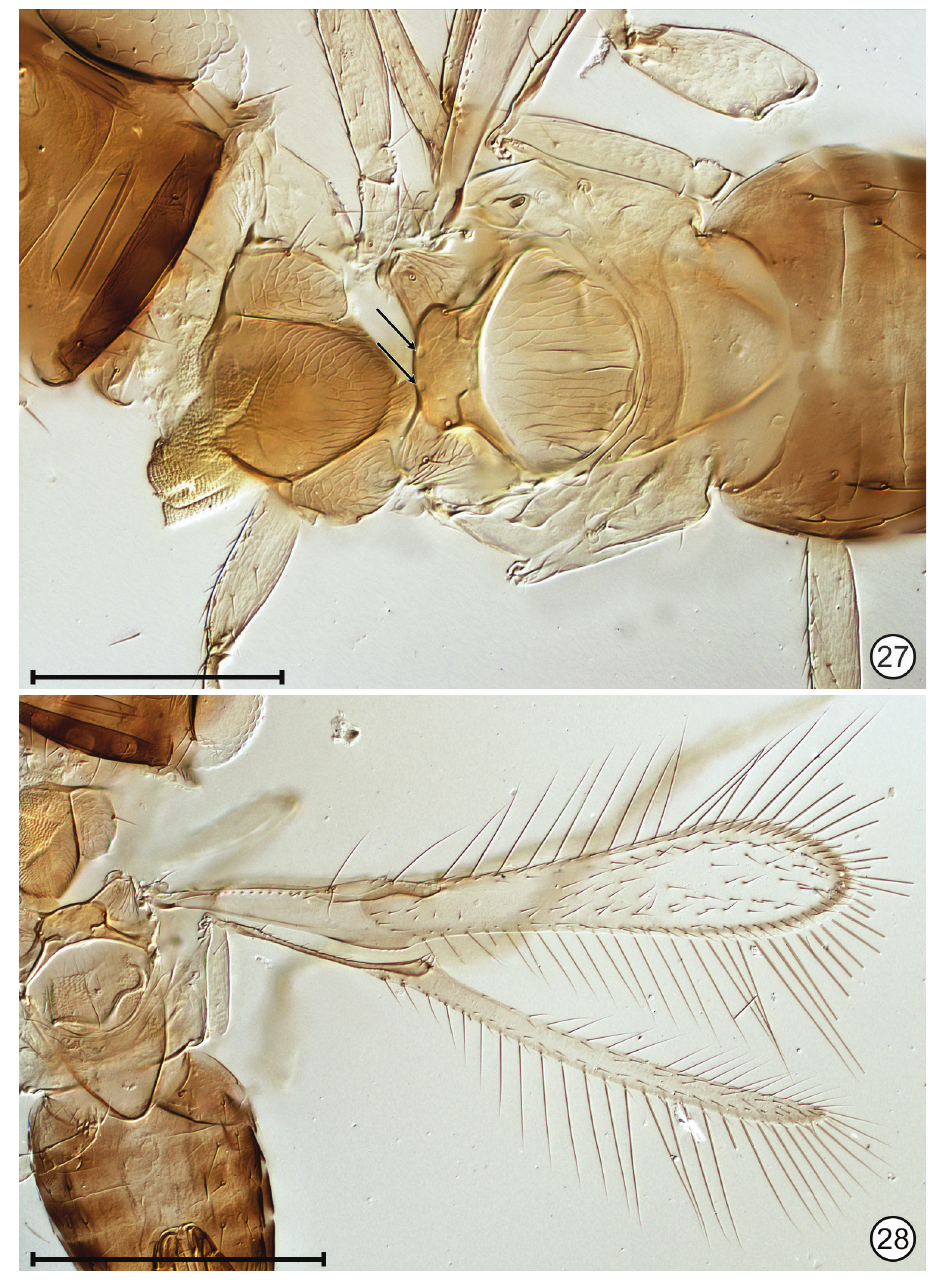
Figures 27, 28. Paranaphoidea occidentalis holotype 27 mesosoma + base of metasoma 28 part of meso- soma and metasoma, and wings. Scale bars: 100 μm ( 27 ), 200 μm ( 28